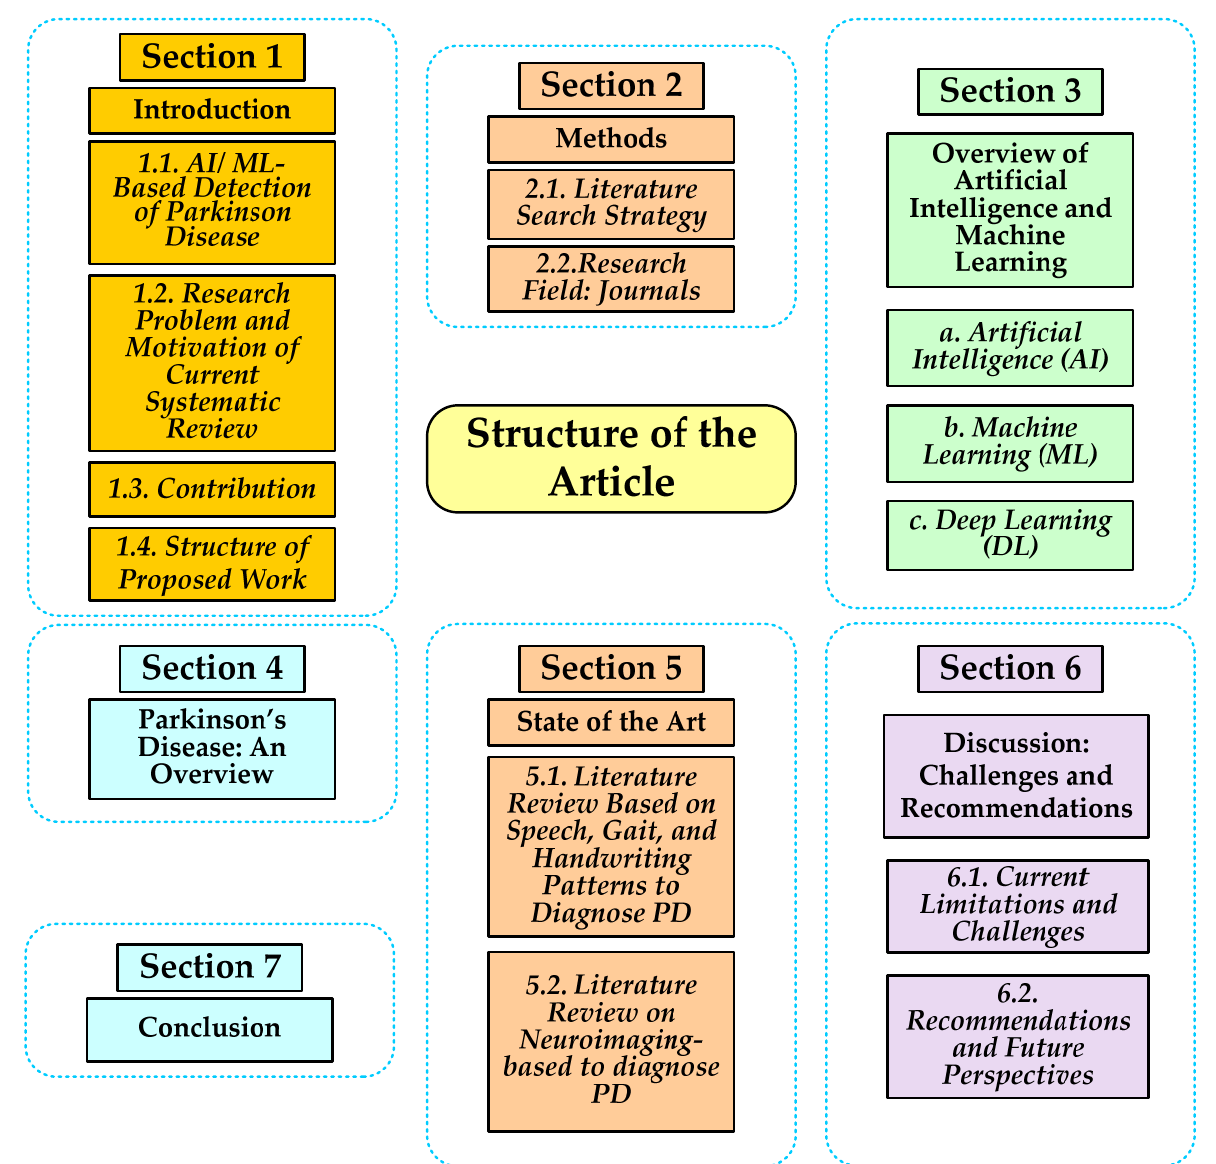
Figure 1. Structure of Proposed Work.